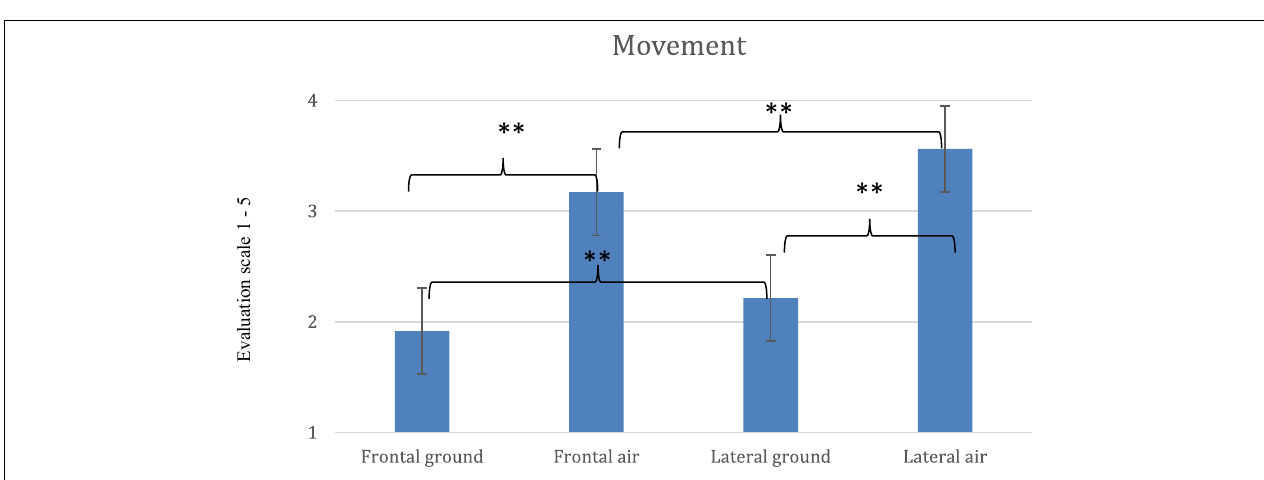
FIGURE 4 | Mean scores for Movement and significant interaction for the four poses, Frontal On-ground , Lateral On-ground , Frontal In-air and Lateral In-air (error bars indicate standard errors of the means; ∗∗ = < 0.001).